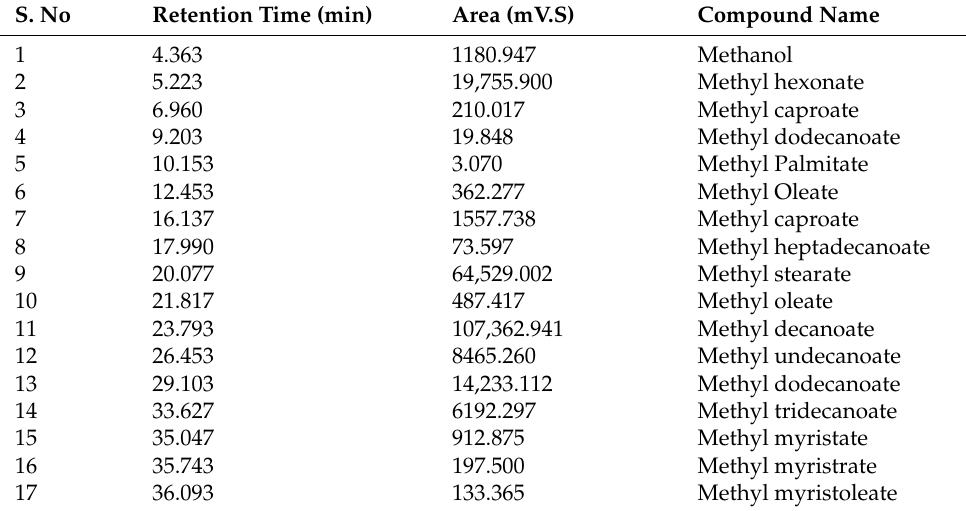
Table 3. Volumetric (%) concentration of tested